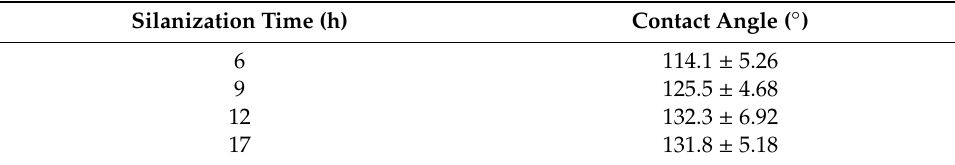
Table 2. Change of coated cellulose aerogel’s water contact angle with silianation time.